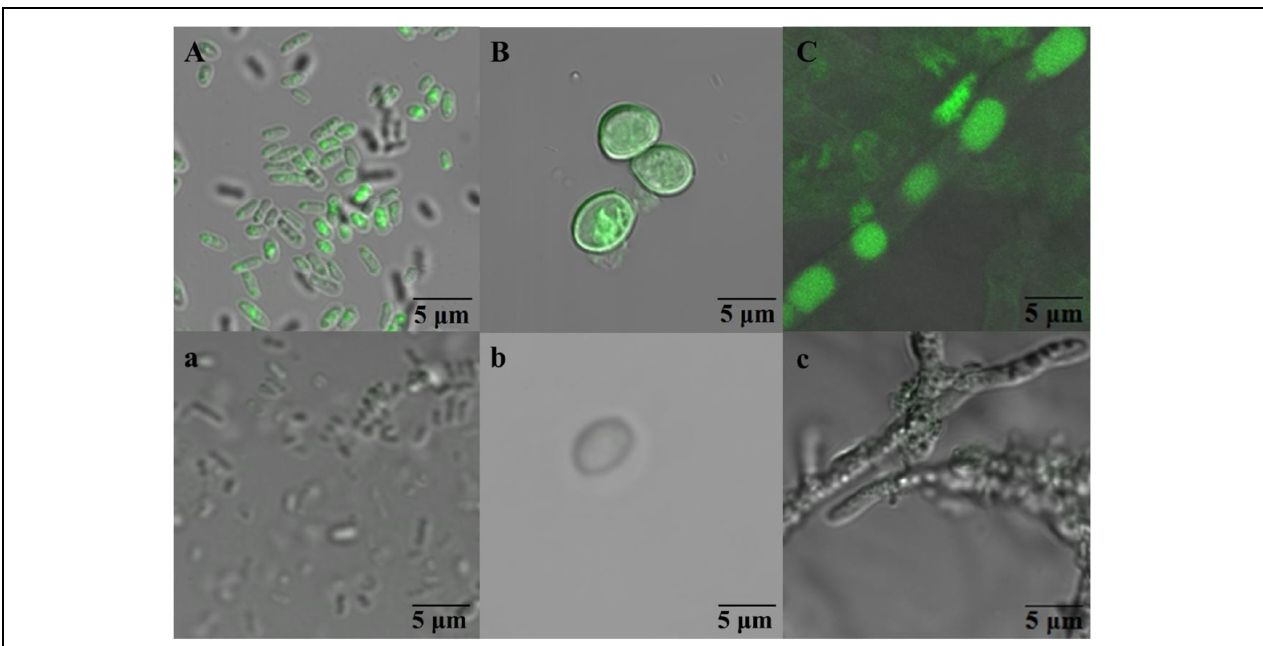
FIGURE 3 | The fluorescent signals observed in Massilia sp. WF1 (A), spore (B), and mycelial pellet (C) of P. Chrysosporium under two-photon excitation microscopy (TPEM). WF1 (A) , the spores (B) , and mycelial pellets (C) of Phanerochaete chrysosporium were incubated 2 h (0.08 days), 3 days, and 3 days with PHE (ca. 1.0 mg L − 1 ), respectively. WF1 (a) , the spores (b) , and mycelial pellets (c) of P. chrysosporium were incubated without PHE. TABLE 2 | Kinetics parameters for PHE dissipation and transport in the intracellular and extracellular of Massilia sp. WF1 and P. chrysosporium at 28 and 4 ◦ C. Massilia sp. WF1 P. chrysosporium Parameters Temperature ( ◦ C) Spore Mycelial